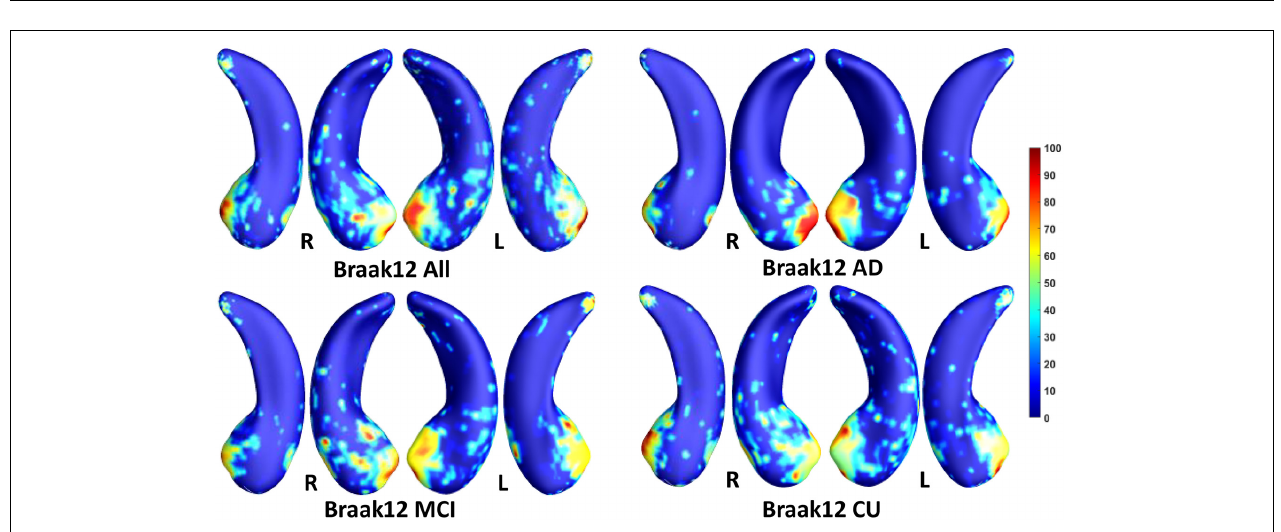
FIGURE 4 | Visualization of ROIs associated with Braak12 (tau measurement). The top left figure shows the results for all subjects. The top right is for AD patients. The bottom two figures are for participants with MCI and for the CU group.